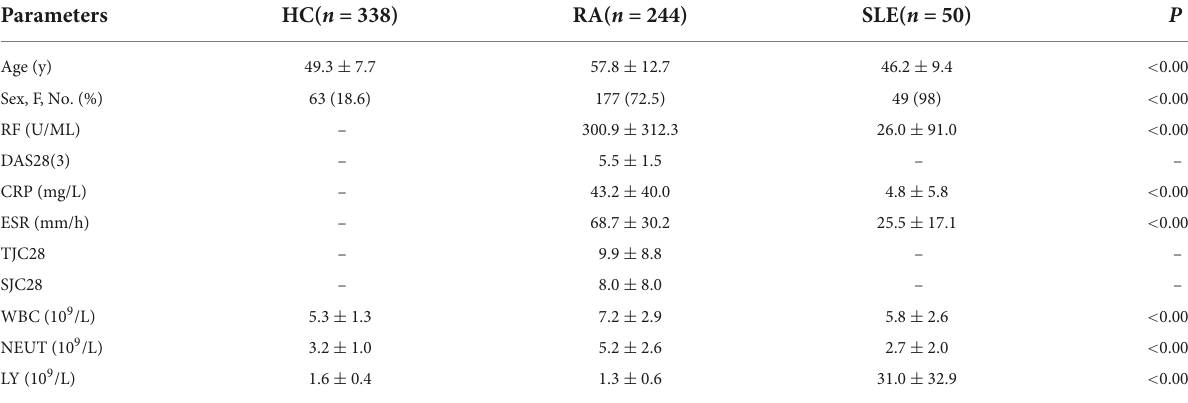
TABLE 1 The characteristics of the patients with RA or SLE and healthy controls.